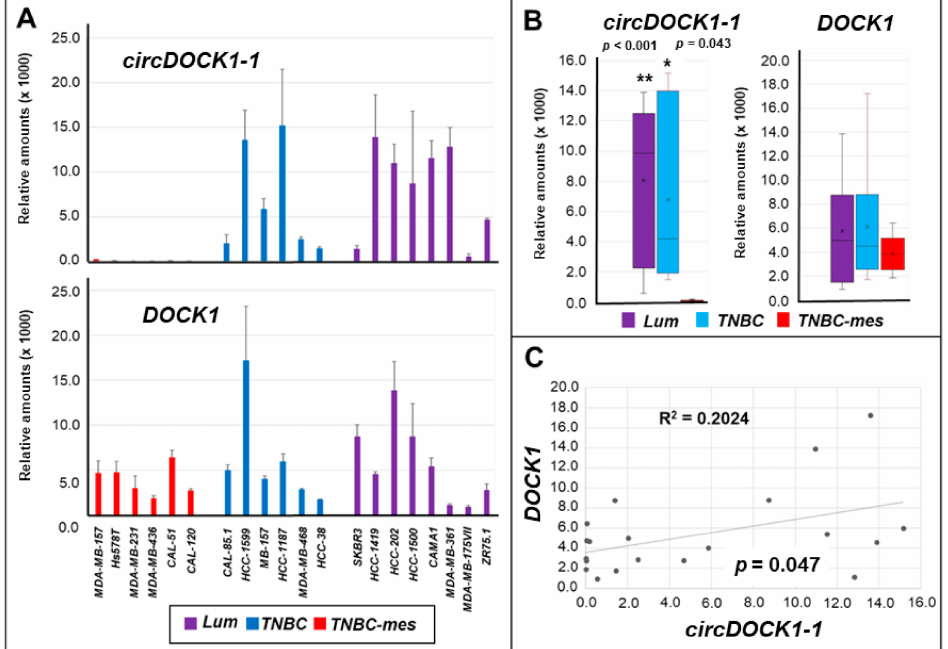
Figure 2. Expression of circDOCK1-1 RNA and the corresponding linear DOCK1 mRNA in breast can- cer cell lines. Total RNA was extracted from the indicated cell lines and the levels of circDOCK1-1 RNA (upper graph) and DOCK1 mRNA (lower graph) were measured by PCR in the indicated cell lines ( A ). Each value is the mean ± SD of 3 independent cultures. ( B ) The panel illustrates the box plots generated from the median expression levels of circDOCK1-1 RNA and DOCK1 mRNA determined in Lum , TNBC , and TNBC-mes cell lines and it summarizes the results shown in ( A ). ** Significantly higher in the Lum relative to the TNBC-mes group, as indicated ( p < 0.001; Student’s T-test). * Signifi- cantly higher in the TNBC relative to the TNBC-mes group ( p = 0.043; Student’s t -test). ( C ) The panel illustrates the correlations between the mean expression of circDOCK1-1 RNA and DOCK1 mRNA in each cell line. The calculated R 2 correlation value (Pearson method) and the correlation p -value are